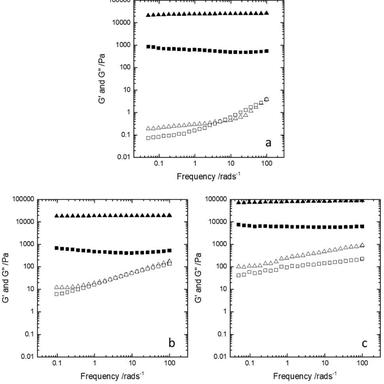
G' (triangles) and G" (squares) as a function of frequency for the agar-based extracts, measured at temperatures of 80 °C (open symbols) and 20 °C (filled symbols). (a) Commercial; (b) HW and (c) NaOH+HW.